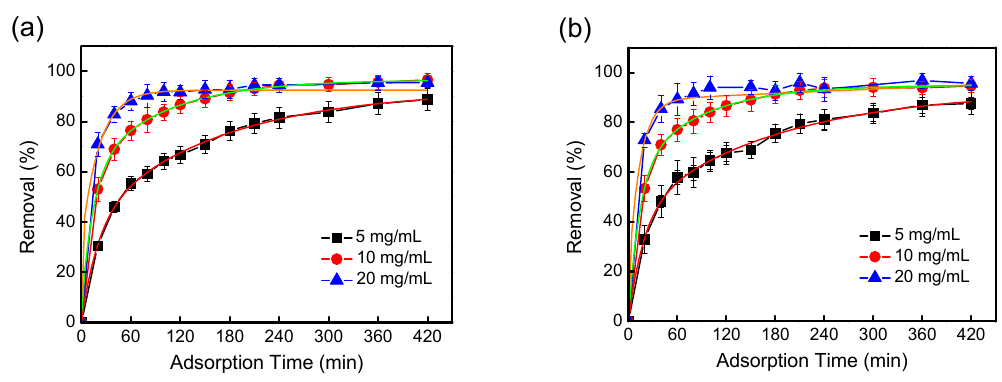
Figure 3. Changes in SDBS adsorption efficiency of ( a ) HP20 and ( b ) HP2MGL with adsorption time at various amounts of adsorbents. [SDBS] = 0.1 mg/mL.